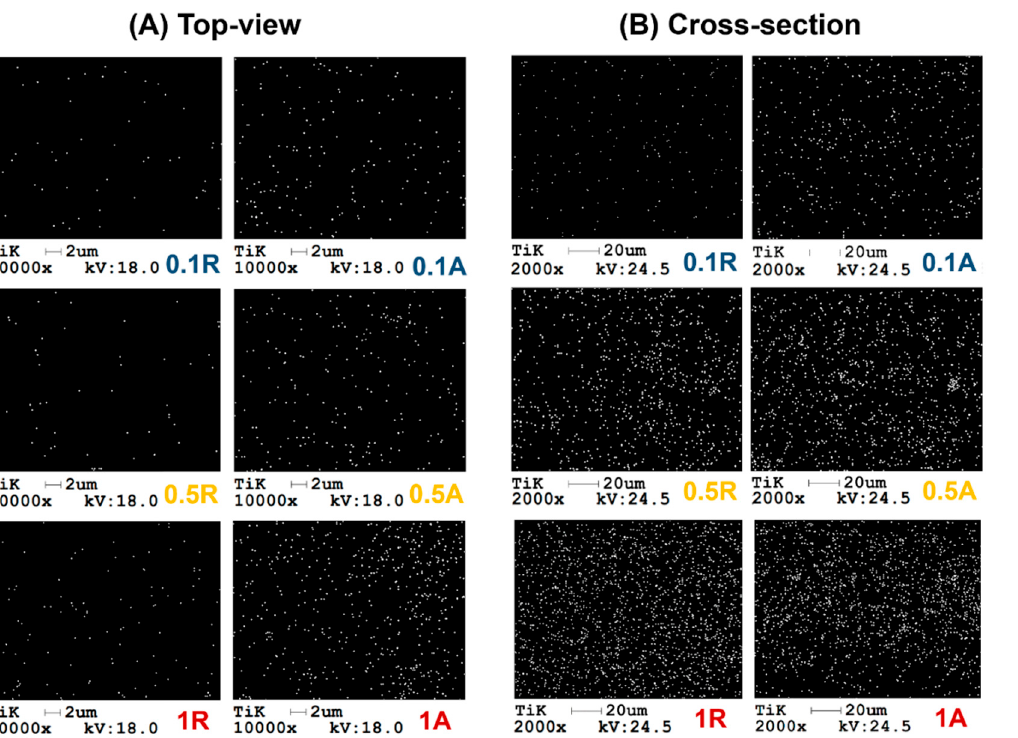
Figure 4. Surface ( A ) and cross-section ( B ) EDX maps of the Ti element for nanocomposite membranes.